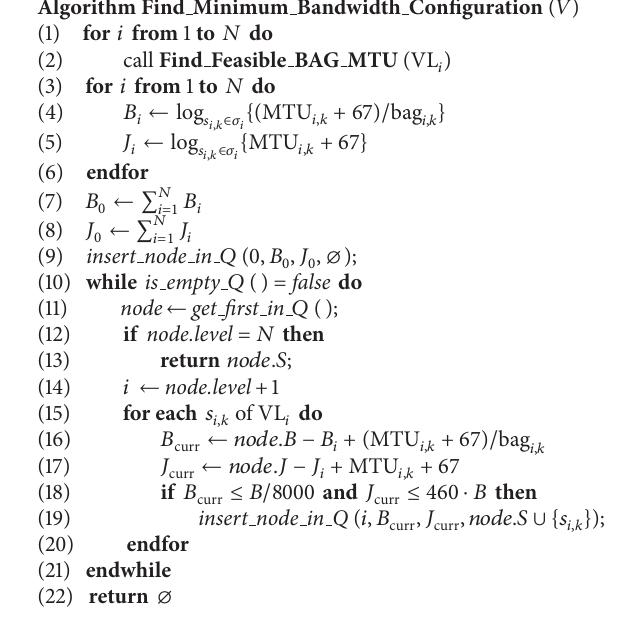
Algorithm 3: The Bounded BFS BandB algorithm.